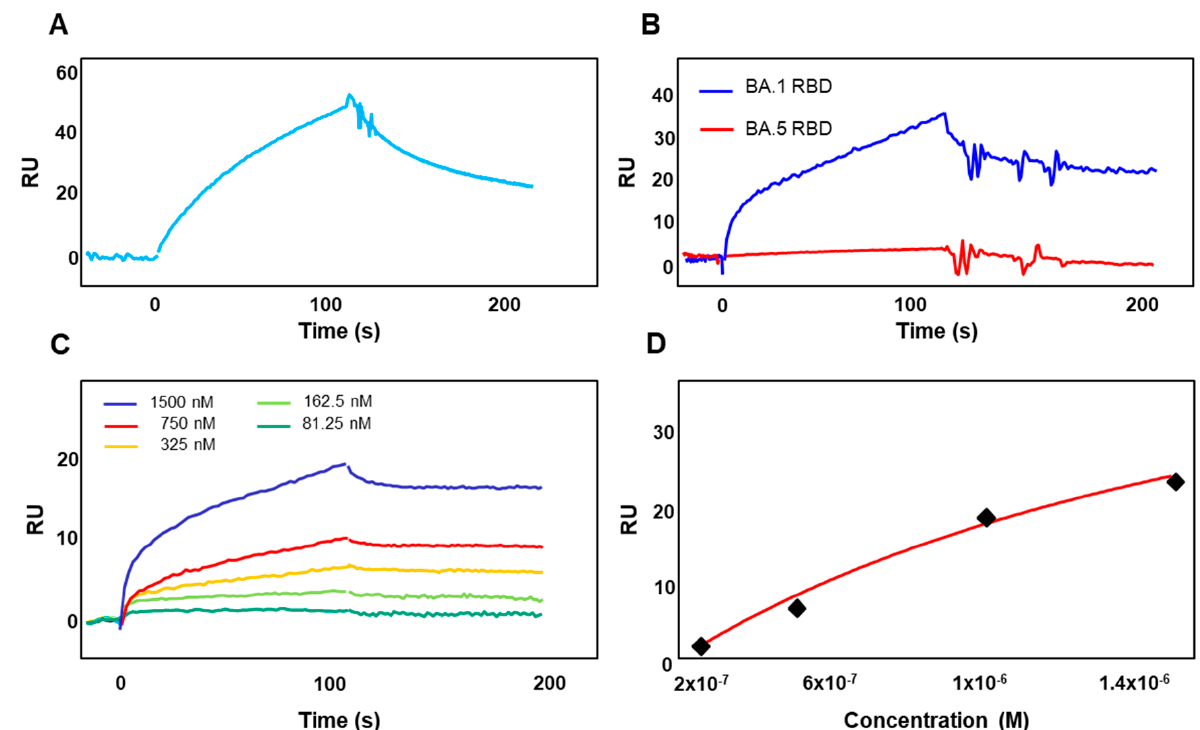
Figure 2. Recombinant RBD of SARS-CoV-2 Spike protein belonging to Omicron BA.5 does not bind to immobilized α v β 3 integrin. ( A ) The specificity of the integrin surface was demonstrated by the binding of the monoclonal antibody against α v β 3 . ( B ) RBD of SARS-CoV-2 Spike protein belonging to Omicron BA.1 (blue line) or Omicron BA.5 (red line) sublineages at a concentration of 1500 nM was injected onto immobilized α v β 3 integrin. ( C ) Sensogram overlay showing the binding of increasing amounts of the RBD of SARS-CoV-2 Spike protein belonging to Omicron BA.1 (from 81.25 to 1.500 nM) sublineage to immobilized α v β 3 integrin. The response in resonance units (RU) was recorded as a function of time. ( D ) Saturation curve obtained by using the values of RU bound at equilibrium from the injection of increasing concentrations of free RBD onto sensorchip immobilized α v β 3 integrin.